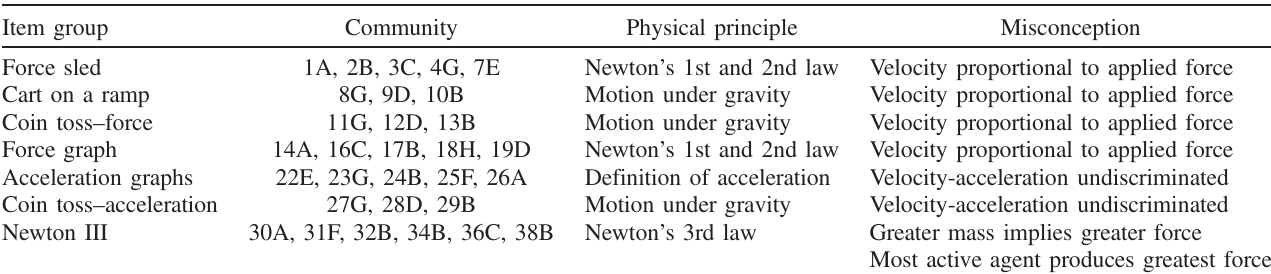
TABLE III. Item groups, the physical principle tested by the group, and the common misconception applied by the students.